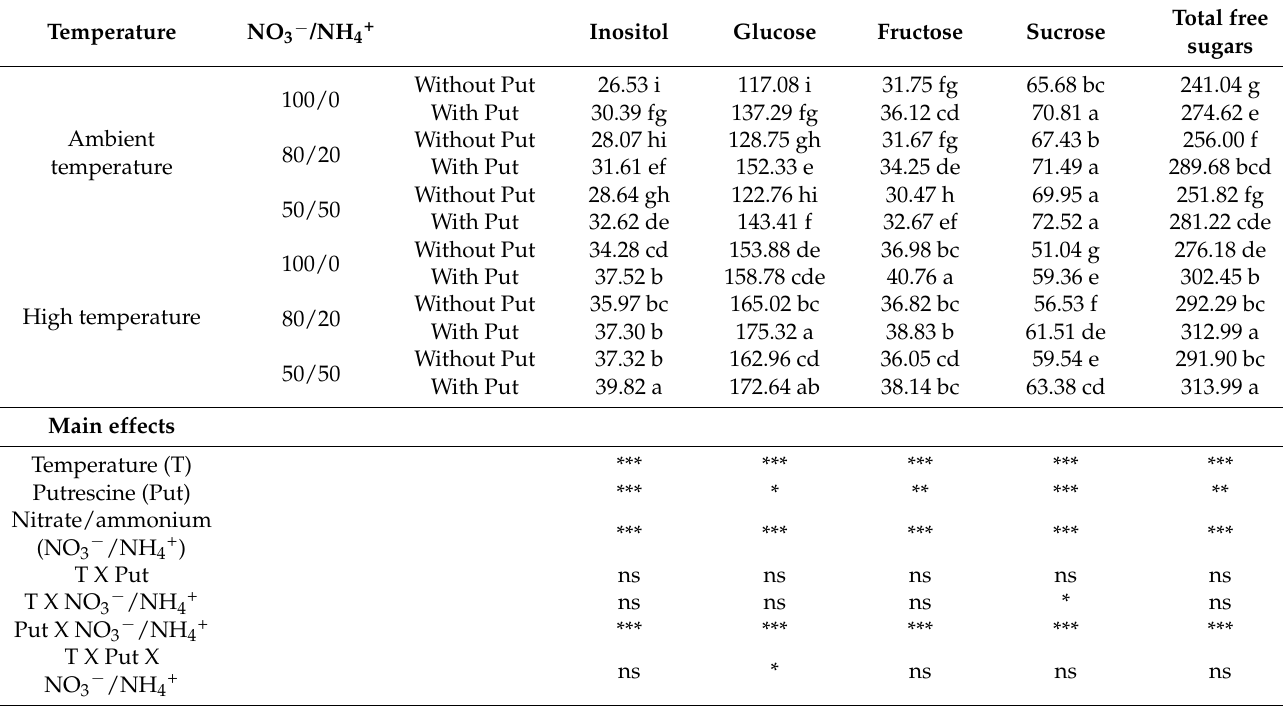
Table 3. Effect of the foliar application of putrescine on the concentrations of sugars (g kg − 1 DW) in younger leaves of the cauliflower cv. Moonshine at different NO 3 − /NH 4+ ratios and